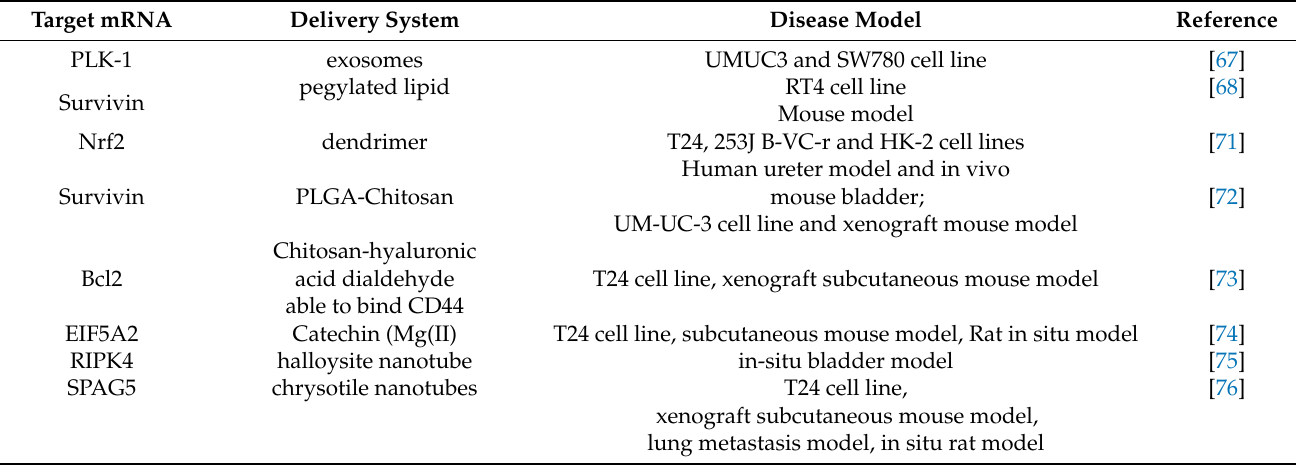
Table 2. siRNA delivery in bladder